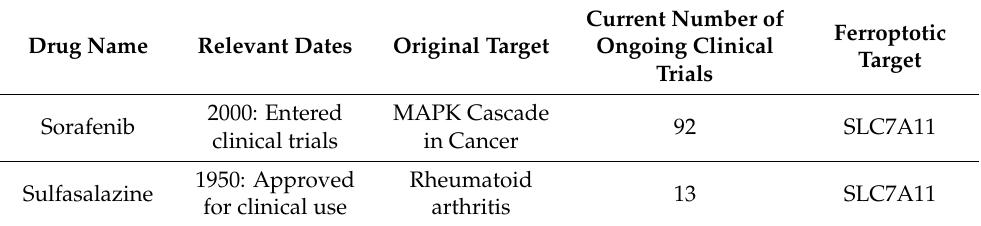
Table 1. Current clinical trials of drugs targeting ferroptosis. Sorafenib and sulfasalazine, neither of which were originally developed for the treatment of ferroptosis, may serve as ferroptosis inhibitors due to their ability to decrease the activity of SLC7A11